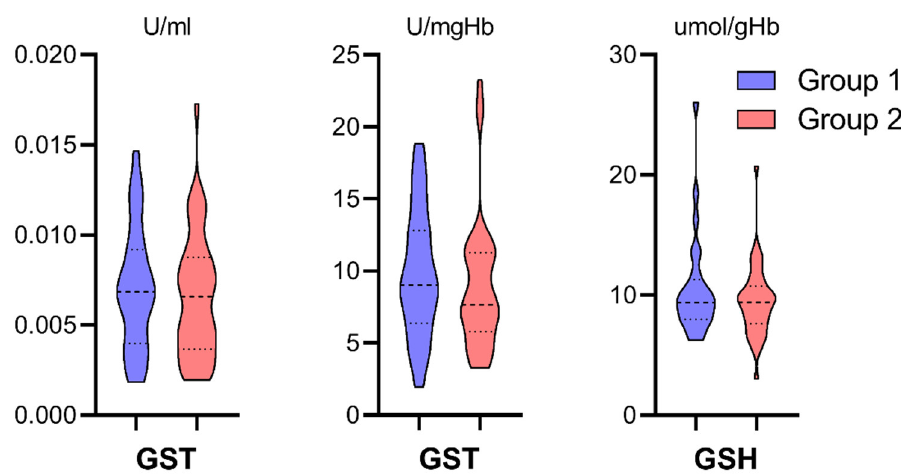
Figure 5. Violin plots of distribution (Mann-Whitney U test, N = 66, n 1 = 26, n 2 = 40): GST activity per volume ( p = 0.6250), GST activity per hemoglobin mass ( p = 0.2639), GSH concentration ( p = 0.5357).